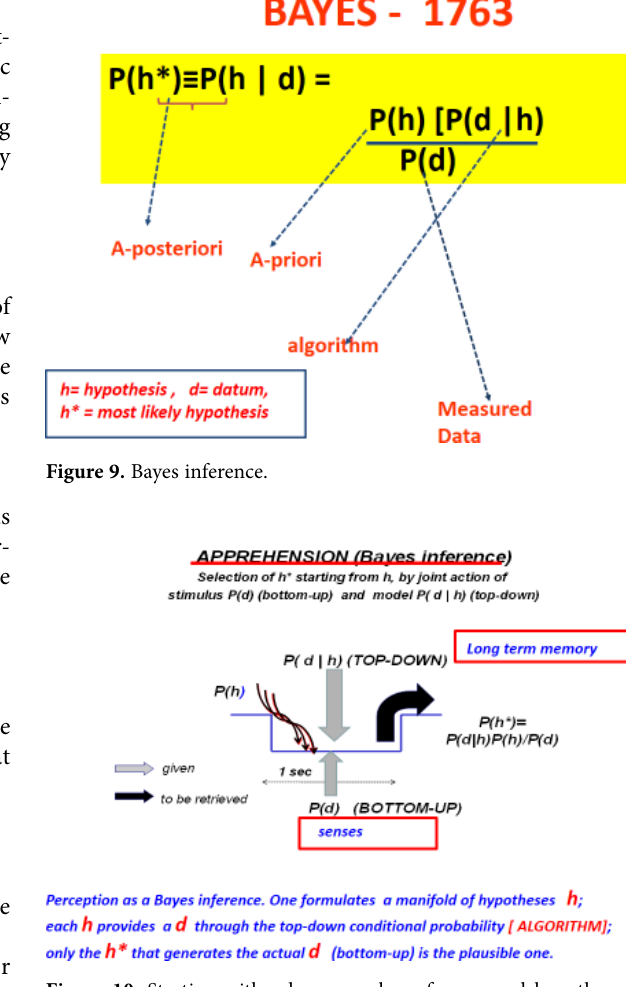
Figure 10. Starting with a large number of presumed hypotheses h, the occurrence of the data selects the h* that satisfies the above relation and drives a suitable